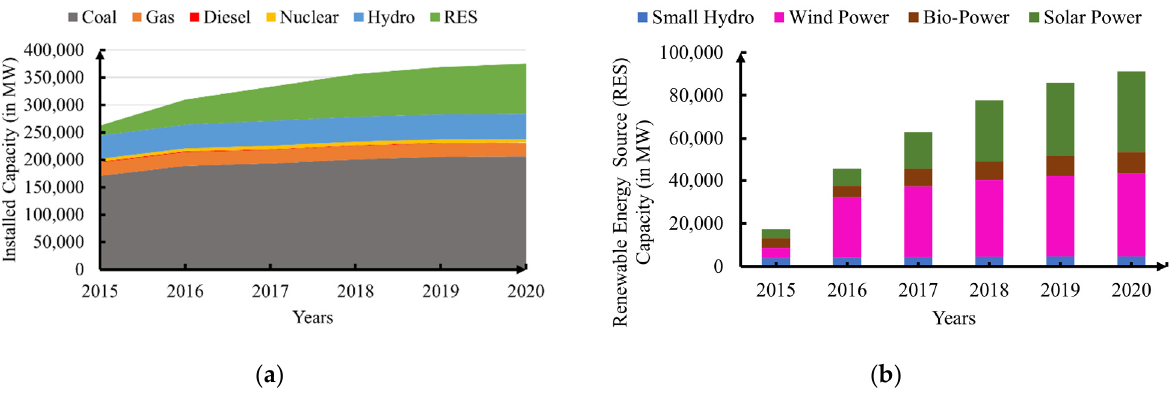
Figure 2. Annual electricity-generation-installed capacity reported by Power Ministry, India: ( a ) Electricity-generation- installed-capacity from all sources. ( b ) Breakdown of power generation by the different renewable energy sources.